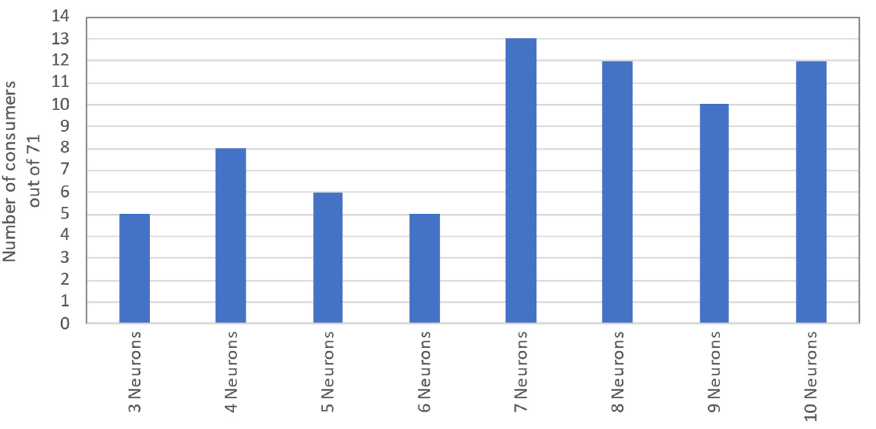
Figure 14. ANN Dimensions’